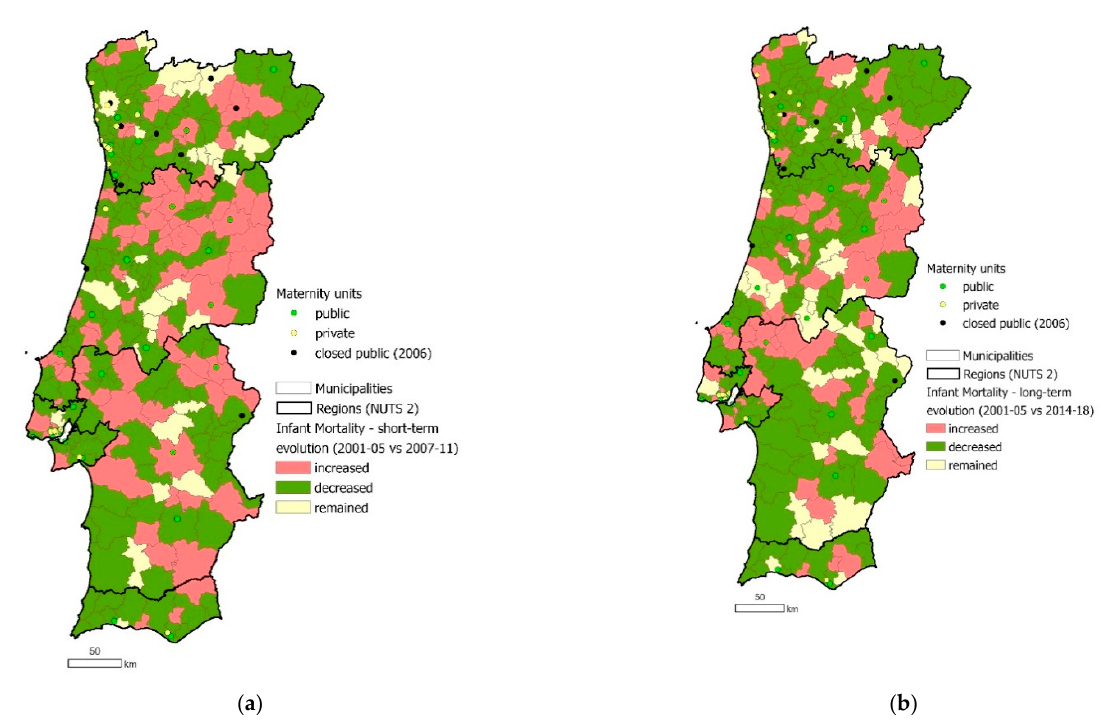
Figure 5. Impact of 2006 policy change on infant mortality (%) by municipality in Portugal in the short term ( a ) and long term ( b ). Source: based on data retrieved from the National Institute of Statistics portal [26], the NHS portal [24] and the Birth Advisor portal [25].